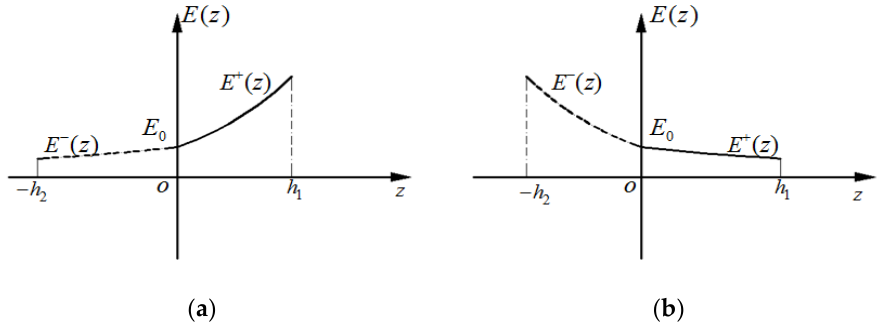
Figure 5. Tensile and compressive moduli and their variations with height direction, in which h 1 and h 2 are the tensile and compressive section heights, E 0 is the neutral layer modulus. ( a ) E + ( z ) > E 0 > E − ( z ); ( b ) E + ( z ) < E 0 < E − ( z ).